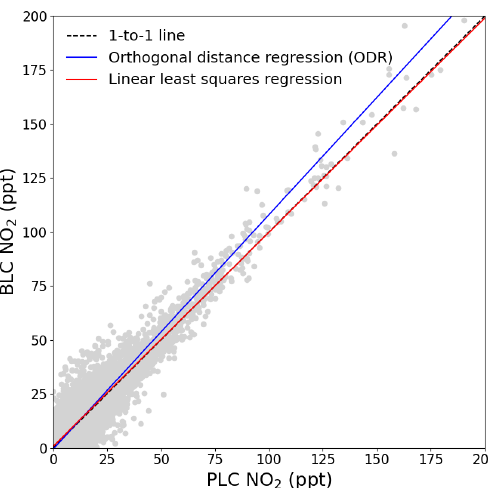
Figure 7. The BLC NO 2 mixing ratio is plotted against the PLC NO 2 mixing ratio. The dashed black line shows the one-to-one re- lationship. The red line is the linear least-squares regression of the hourly data with uncertainty in the y axis, and the blue line is the orthogonal distance regression with uncertainties in both the x and y